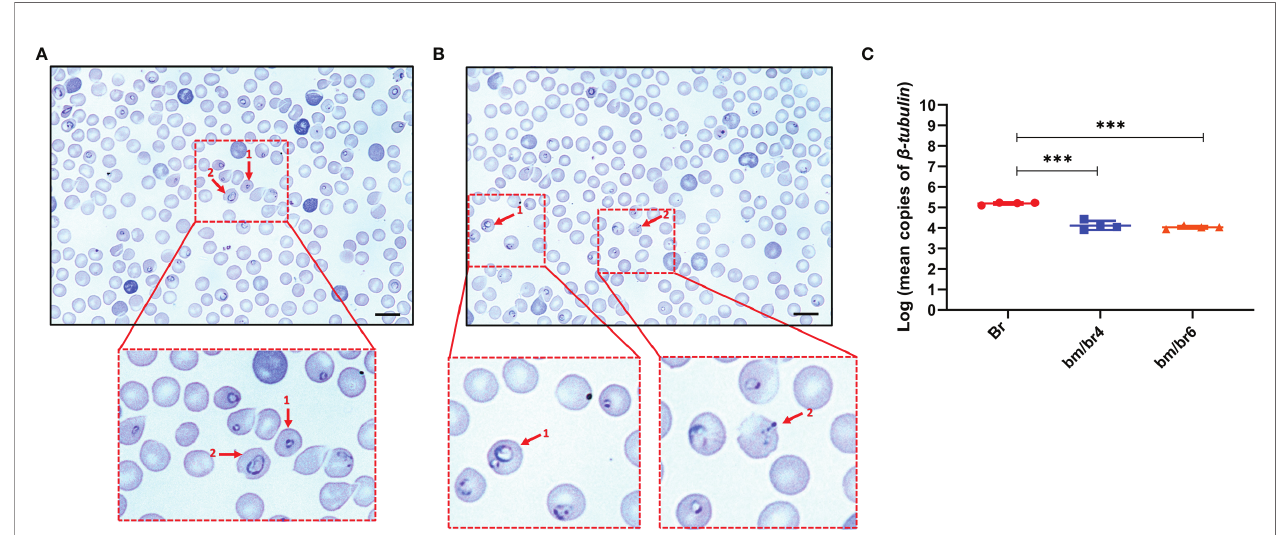
FIGURE 2 | Giemsa-stained thin blood smear showing (A) 1, B . microti ; 2, B. rodhaini infecting mouse erythrocytes and (B) 1, B. microti and B. rodhaini infecting the same erythrocyte; 2, crisis form of Babesia . Bars represent 10 m m. (C) Mean copy numbers of B. rodhaini b -tubulin in mouse DNA samples (n = 4 per group at day 4 post-challenge infection) were transformed to log values. Individual values are the mean of duplicate samples. Log values were analyzed using one-way ANOVA and Tukey ’ s multiple comparison post-hoc test; *** p <